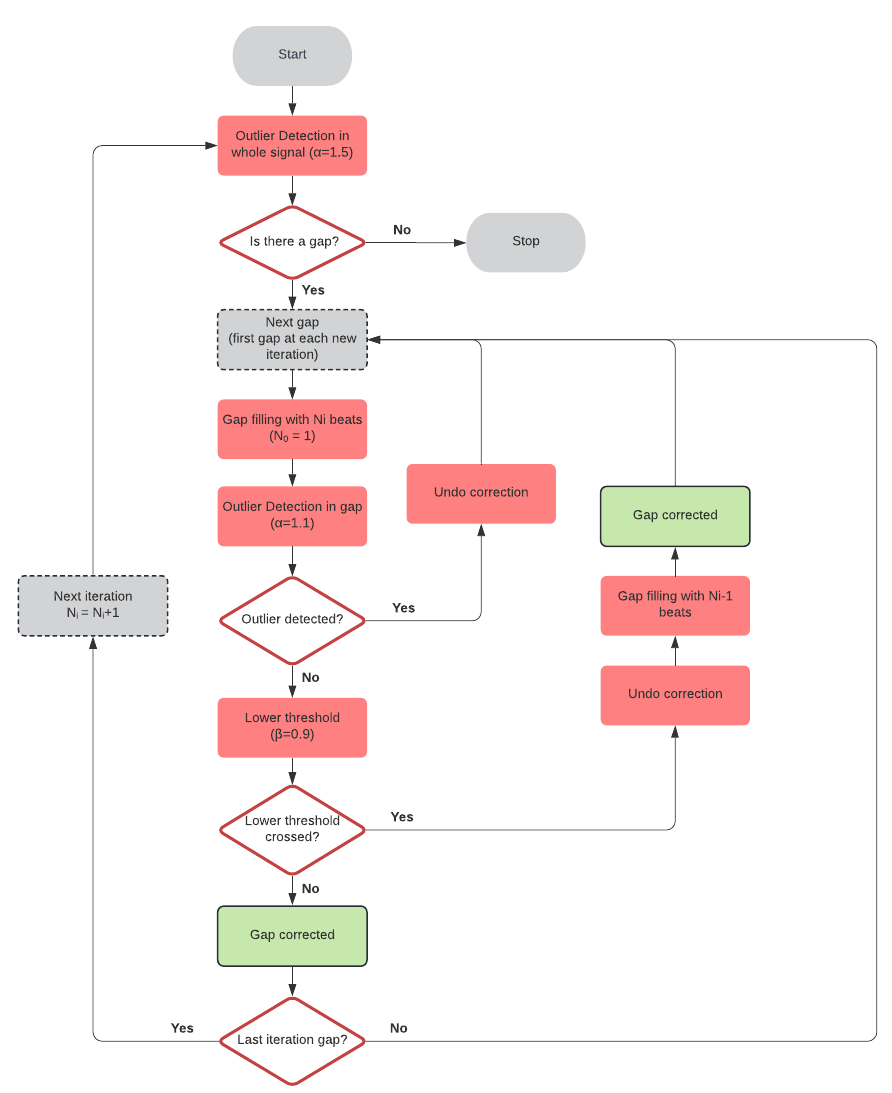
Figure 3. Gap-filling algorithm